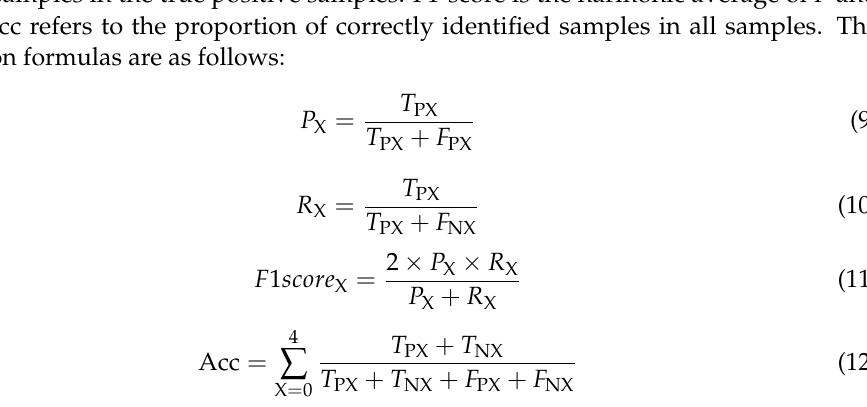
Figure 14. The confusion matrix of age range prediction model by midpalatal suture image features verified in the test set.